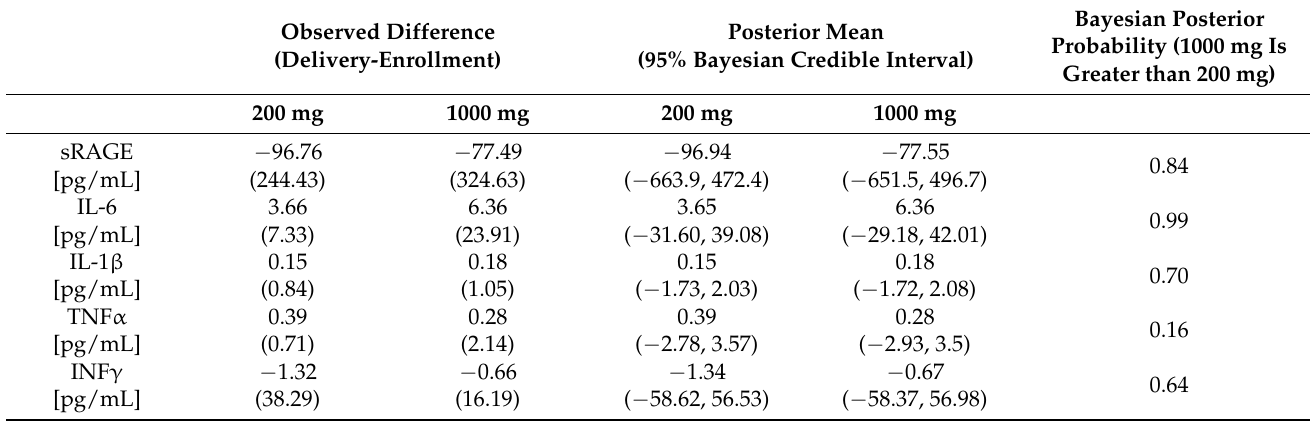
Table 4. Change in sRAGE/cytokine levels between enrollment and delivery, posterior means of the change (Bayesian credible intervals), and Bayesian posterior probability with treatment group (alone) as a